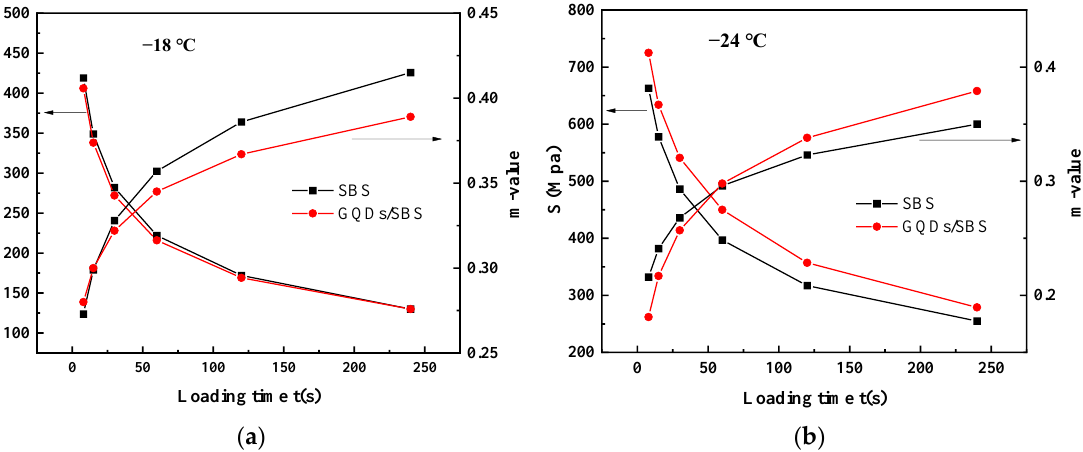
Figure 13. Evolution of S and m-value versus loading time for GQDs/SBS composite-modified asphalt and SBS-modified asphalt at ( a ) −18 and ( b ) −24 °C.